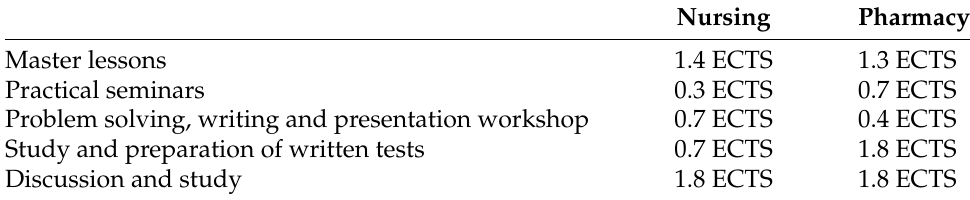
Table 6. Structure of the subjects under